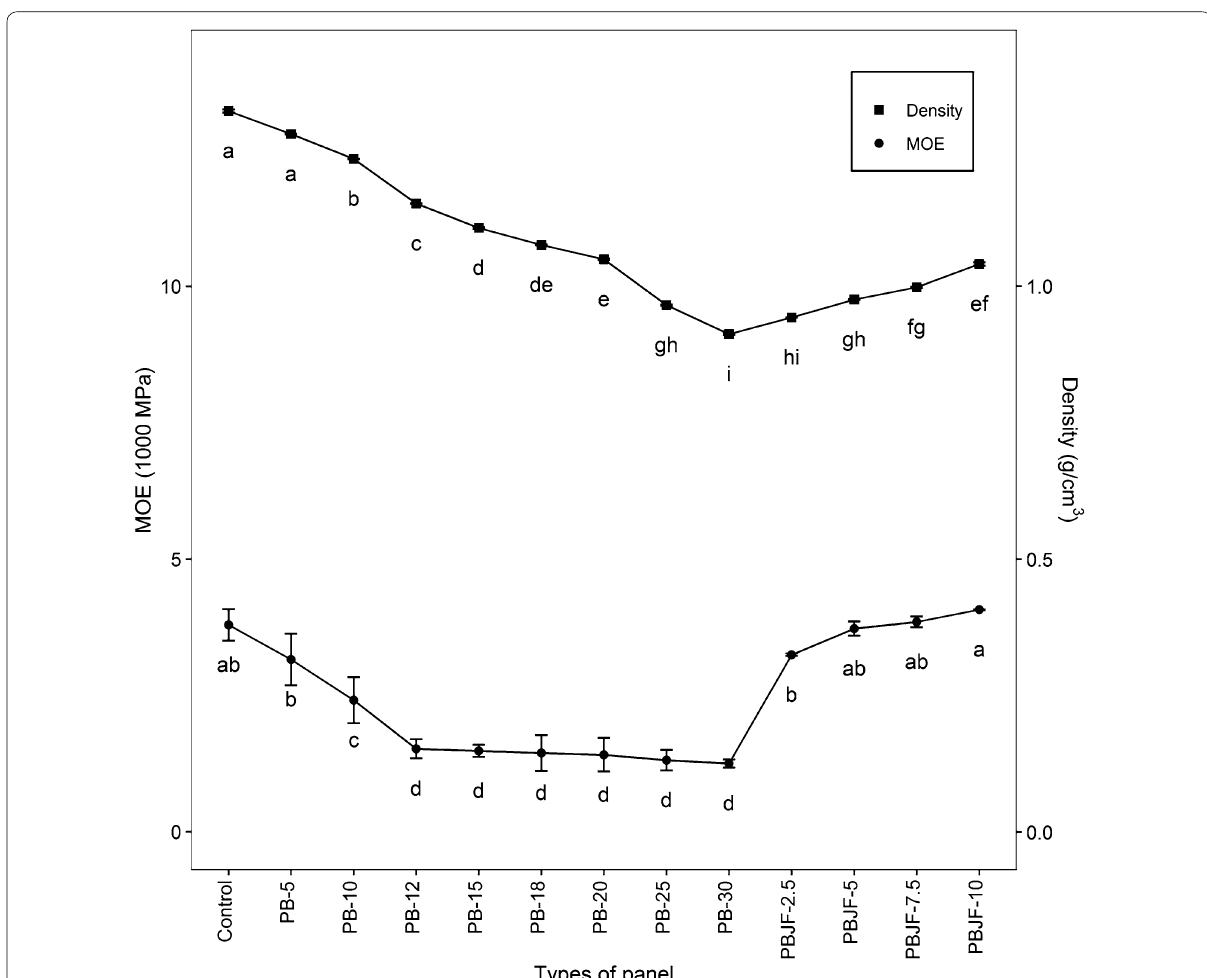
Fig. 4 Modulus of elasticity and density variation for different types of CBCs. Different letters below each point indicate statistically significant differences among groups ( p <